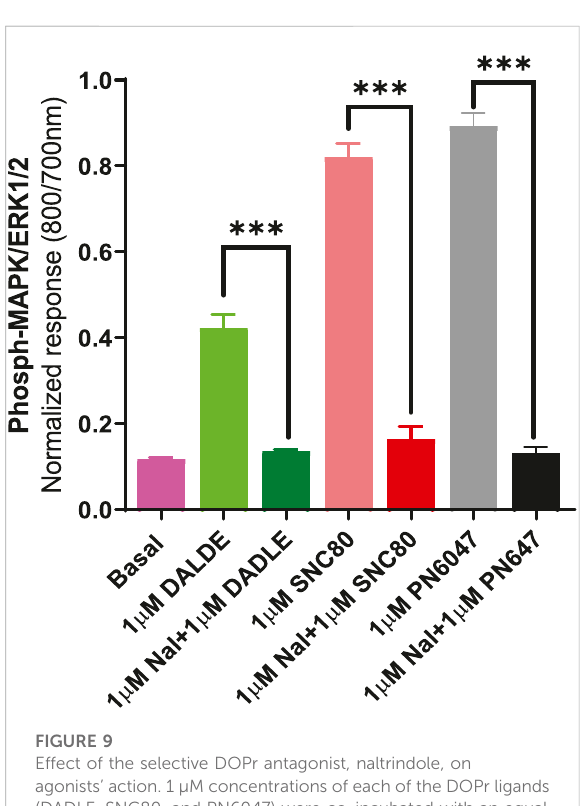
Potency (EC 50 , logEC 50 ) and ef fi cacy (E max ) values for DOPr agonist activation of ERK1/2 in CHO-K1-hDOR cells. Shown are the mean values ± SEM from four separate experiments, performedasdetailedundertheMethodssection,withthemaximumresponseinducedbySNC80de fi nedas100%.* p < 0.05showssigni fi cantlylesspotencyoref fi cacythanSNC80;one- way ANOVA, followed by Dunnett ’ s multiple comparisons test.